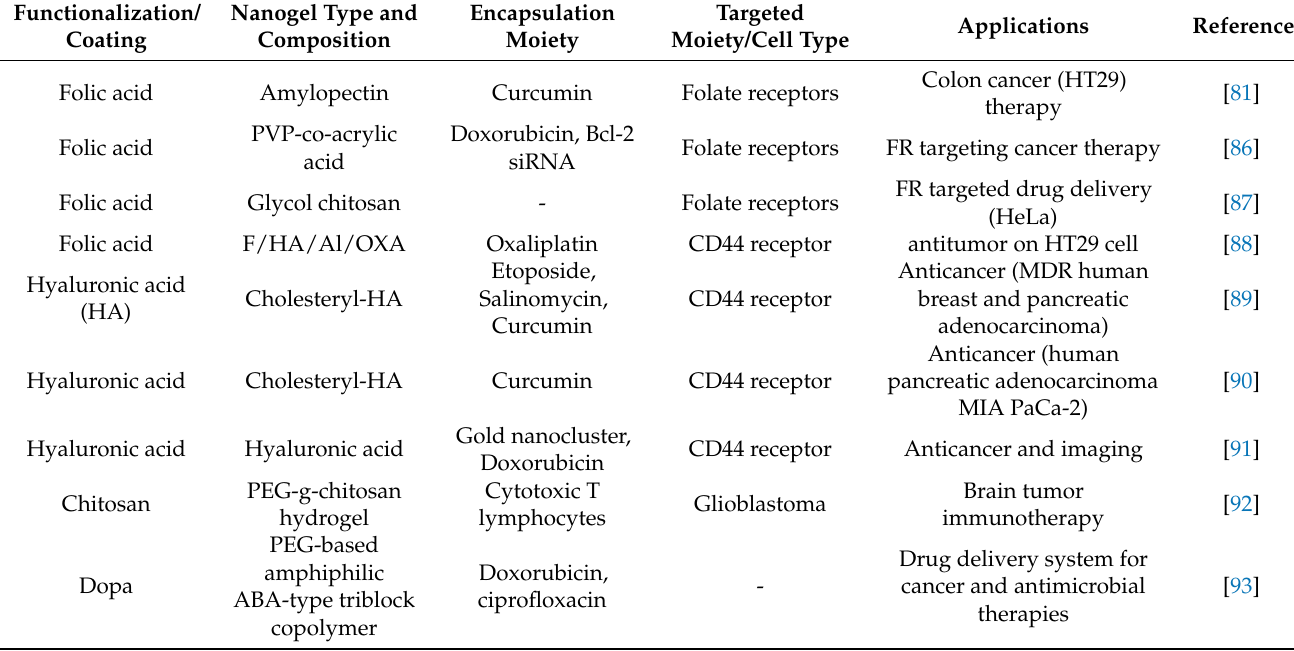
Table 2. Functionalized NGs-based approaches in cancer